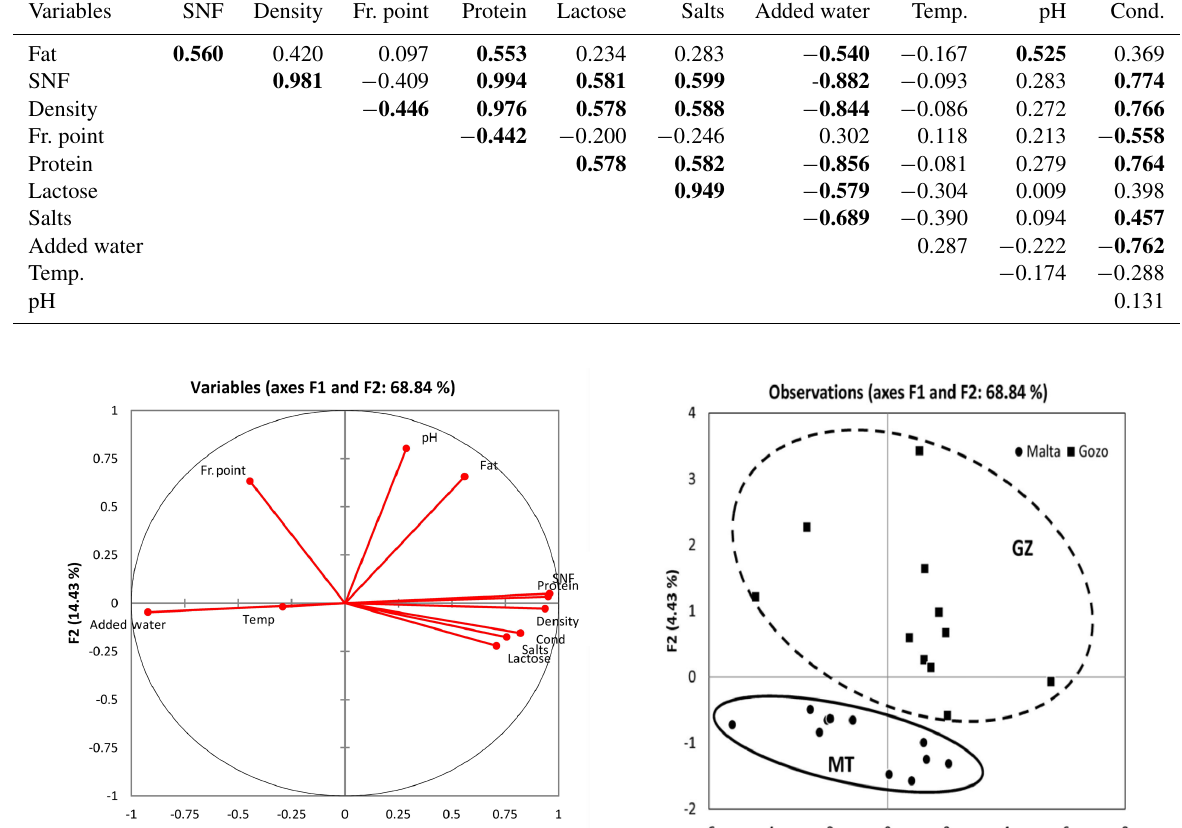
Results on mineral content are presented in Table 6. The GZ farm exhibited higher Pb and Cu content than MT. Lead concentrations in both farms exceed the maximum limit of 0.02 mg kg − 1 (EU Regulation 2001/466 for bovine